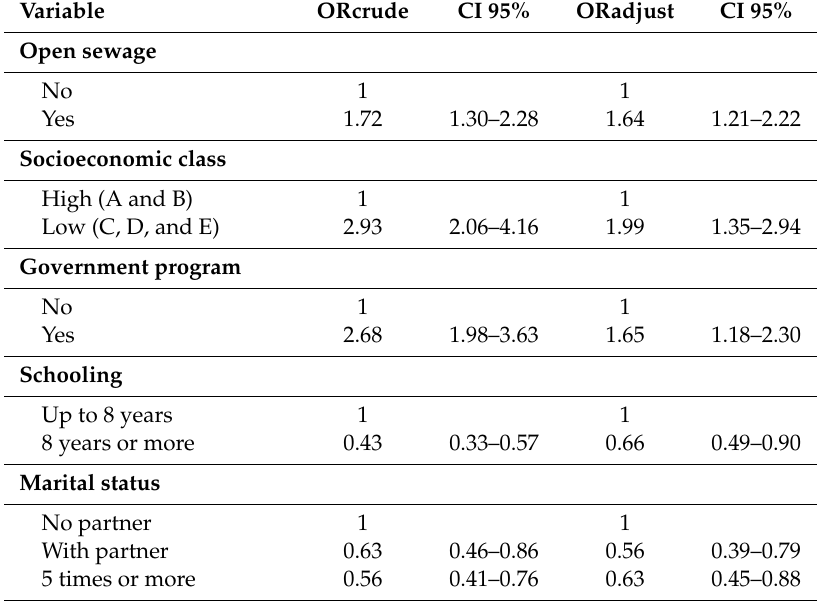
Table 5. Factors associated with food insecurity during pregnancy in a cohort in Rio Branco, AC, 2015.